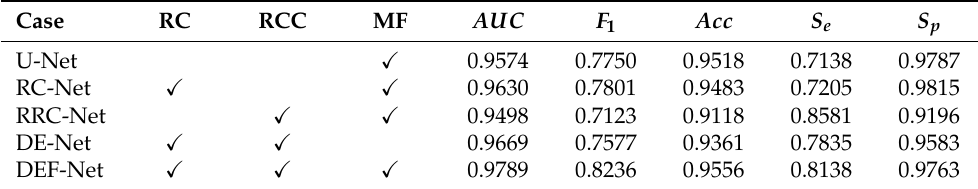
Table 1. Ablation experiment on DRIVE dataset.